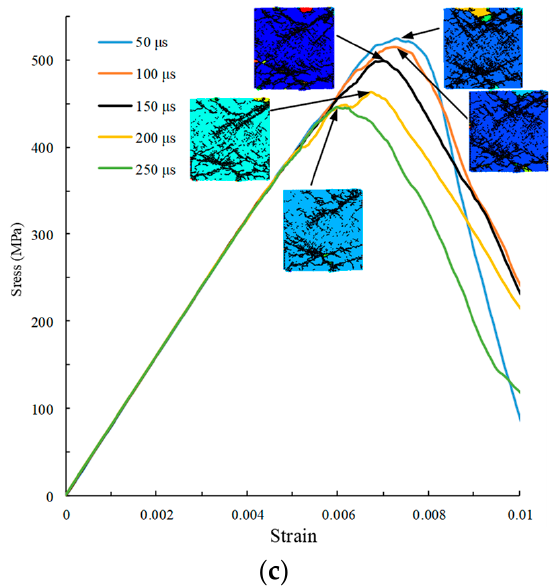
Figure 7. Curve calculations under different slopes. ( a ) Time history curves of incident stress wave; ( b ) time history curves of strain rate; ( c ) stress–strain curve.